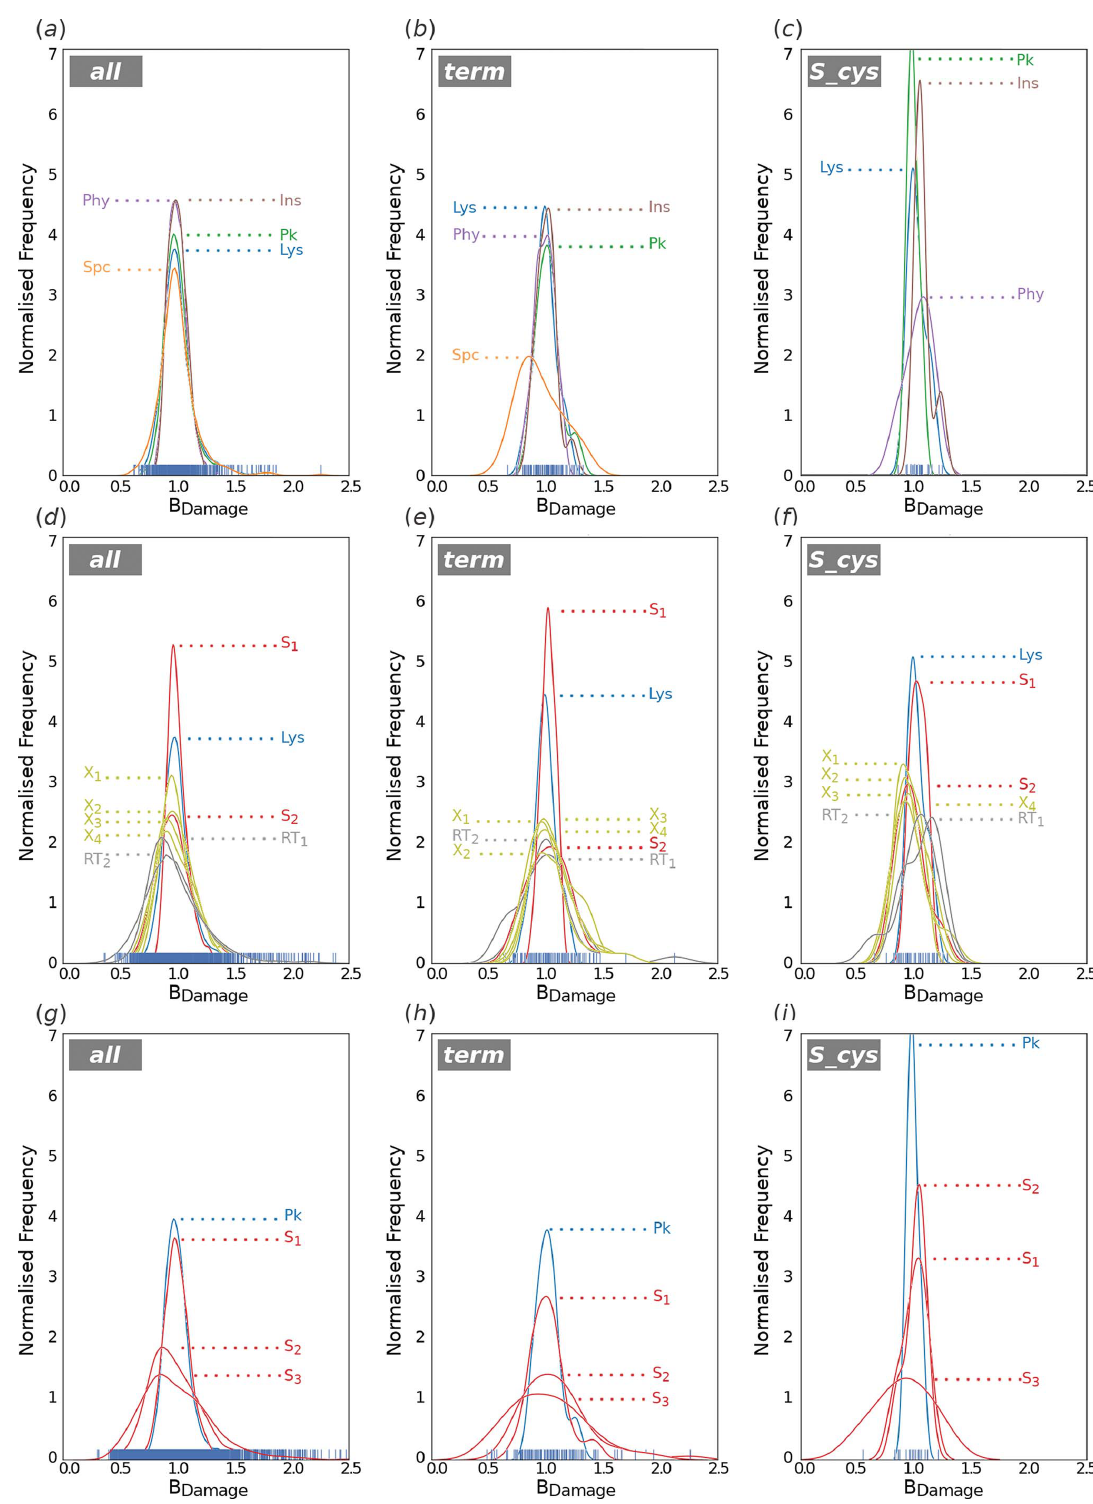
Figure 4 B Damage analysis. Distribution of protein structures of those obtained in the present work (top) and of two comparisons of the lysozyme (middle) and proteinase K (bottom) structures with other reference structures considering all protein atoms [ all ; parts ( a ), ( d ) and ( g )], the terminal GLU O " , ASP O (cid:6) and CYS S (cid:4) atoms [ term ; parts ( b ), ( e ) and ( h )] or only CYS S (cid:4) atoms [ S_cys ; parts ( c ), ( f ) and ( i )]. In the top panels [parts ( a ), ( b ) and ( c )], lysozyme (Lys) is depicted in blue, phycocianin (Phy) in purple, proteinase K (Pk) in green, spectrin C (Spc) in orange and insulin (Ins) in brown. The lysozyme (middle) and proteinase K (bottom) structures of this article are shown in blue and the reference structures are shown in red; other SSX structures (Martin-Garcia, 2021) collected with a high-viscosity injector at other synchrotron beamlines (middle: S 1 4rlm and S 2 5uvj; bottom: S 1 5uvl, S 2 6fjs and S 3 6mh6) are shown in red and XFEL structures (middle: X 1 5dm9, X 2 6h0k, X 3 7byo and X 4 6h0l) are shown in yellow, while synchrotron structures collected at room temperature in oscillation mode are shown in grey (middle: RT 1 1iee and RT 2